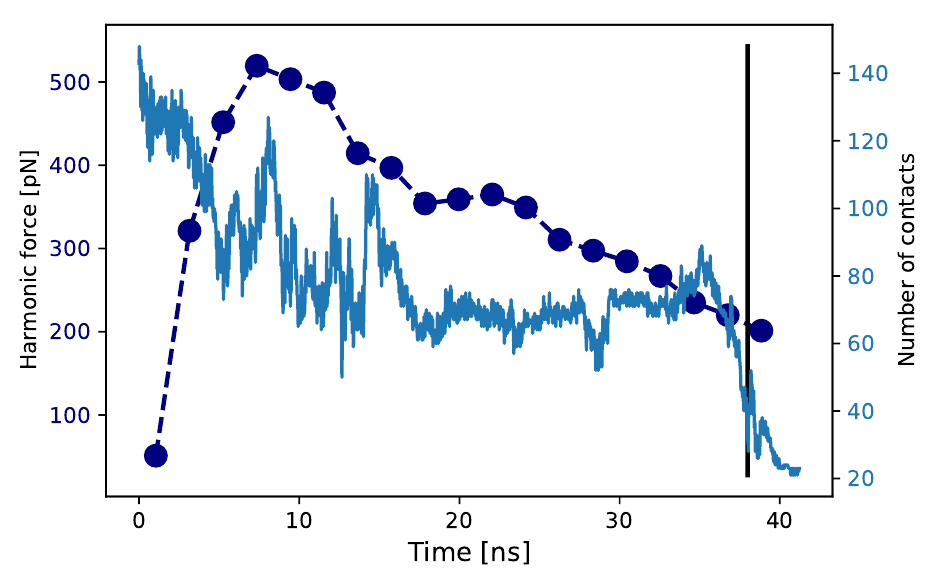
Figure 8. Tensile force. Time evolution of the mechanical force acting at the A2 terminus connected to the L 12 linker (dark blue). The force is estimated as a moving average over a time window of 2.1 ns. We also report the time evolution of the coordination number of 111 Tyr (light blue) until the full exposure criterion is reached, as shown by the vertical line at